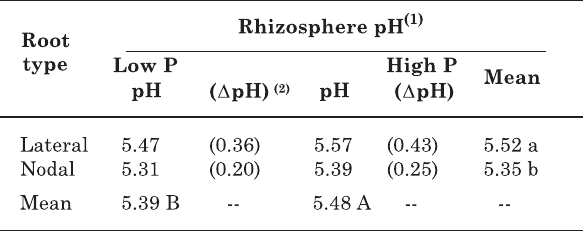
Table 5. Mean rhizosphere pH values of lateral and nodal roots of maize genotypes grown at low and high soil P levels